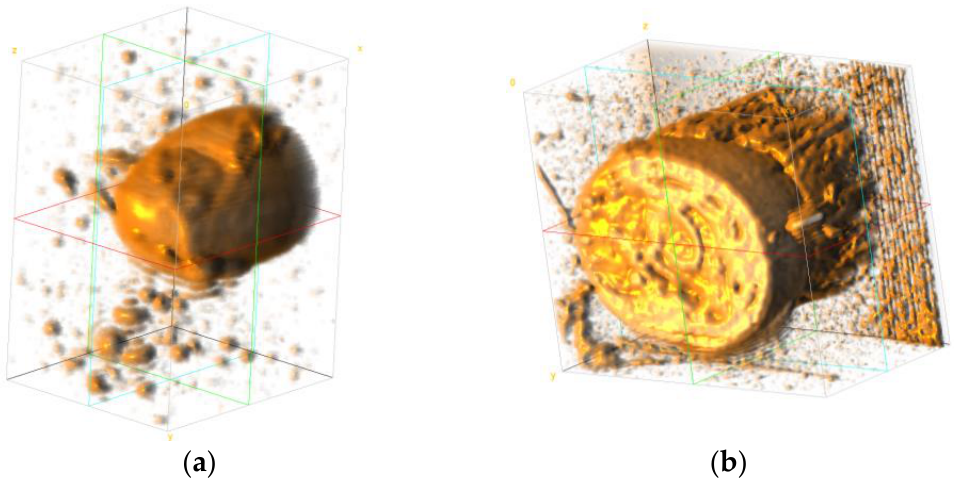
Figure 4. 3D MR image data ( a ) fingertip section, ( b ) wrist section.